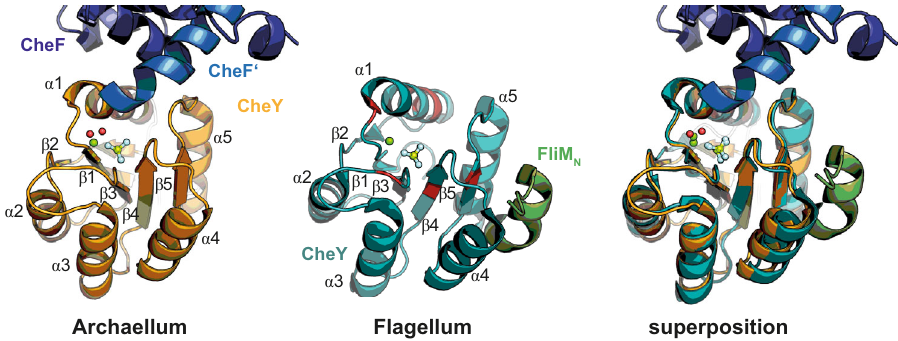
Fig. 5 Structural comparison between CheY bound to CheF and FliM N . Superposition of CheY bound to CheF and CheY bound to the N-terminus of FliM (FliM N ; PDB: 1F4V). Ec CheY is colored in cyan and FliM N in smudge. Residues identi fi ed in ref. 29 important for FliM M interaction at CheY are colored in